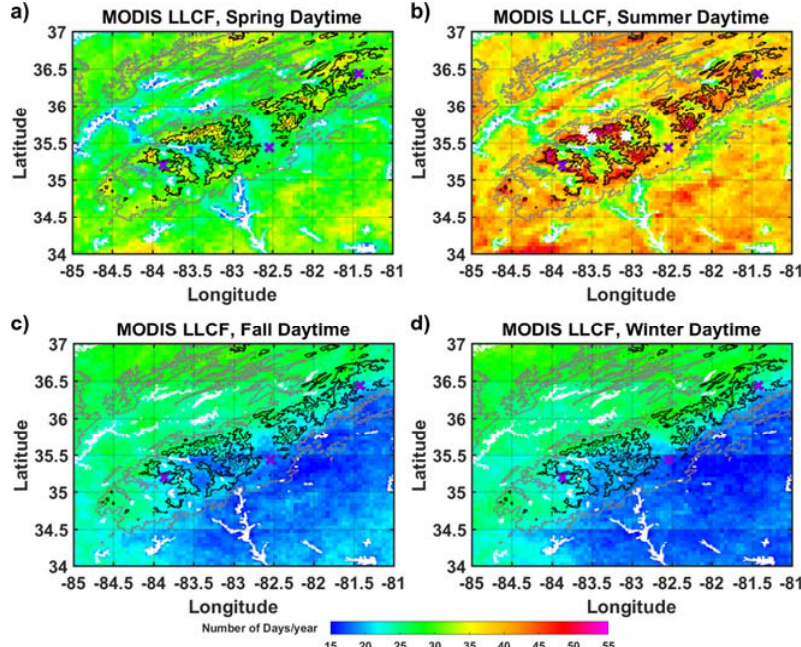
Figure 13. Spatial distributions of MODIS LLCF (CTH <5 MSL, single-layer clouds only) occurrences in each grid box (0.05° × 0.05°) during daytime overpasses for each season (spring: April–June; ( a ) summer: July–September; ( b ) fall: October–December; ( c ) and winter: January–March; ( d ) Contour lines mark terrain elevation of 500 m (solid grey), 1000 m (solid black) and 1500 m (dotted black) and water surface is delineated by white dots. Note the three ground ceilometer sites (from left to right: KRHP, KAVL, and KGEV) are marked by purple crosses and white asterisks in ( b ) denote the four ground fog collectors (from left to right: ELK, CD, PK, and PKT).